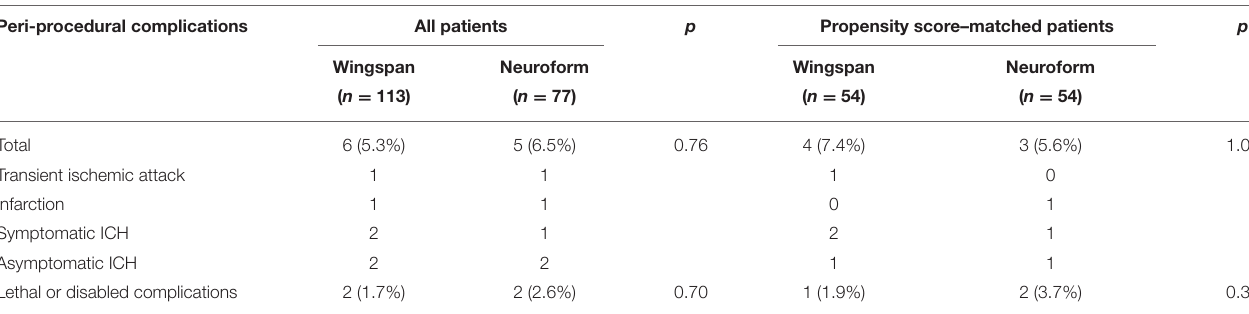
TABLE 2 | Peri-procedural